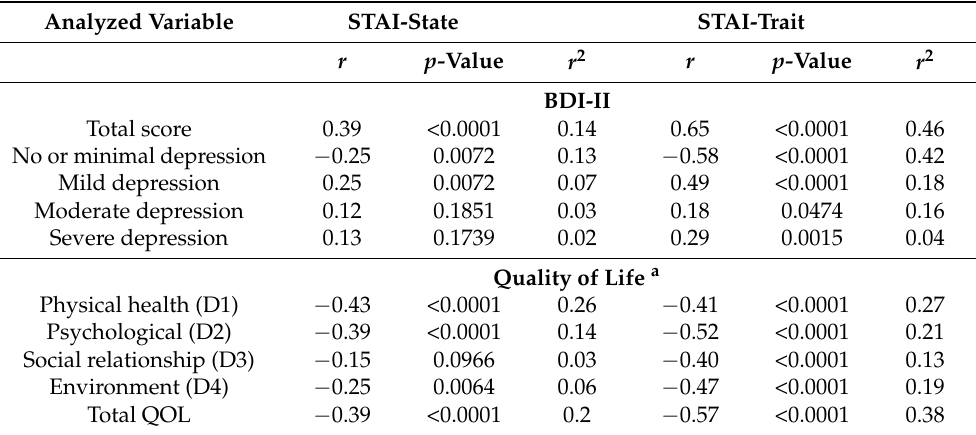
Table 3. Association between anxiety, depression, and quality of life in patients undergoing diagnostic